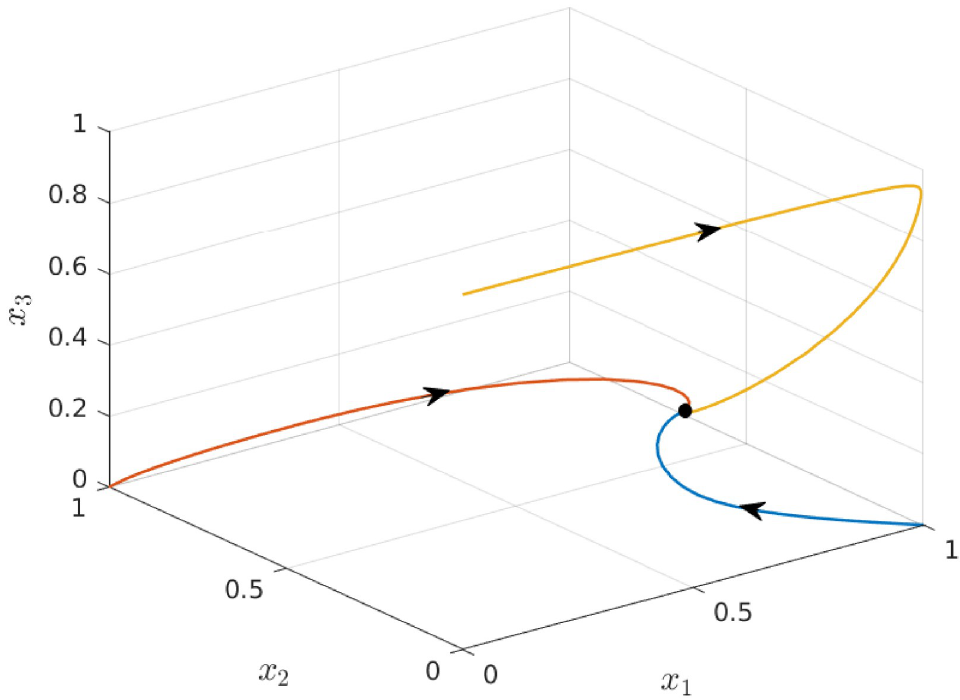
Fig 17. Trajectories of RFMEOD for three initial conditions given in Example 14 as a function of time. The equilibrium point is marked by a ellipse.